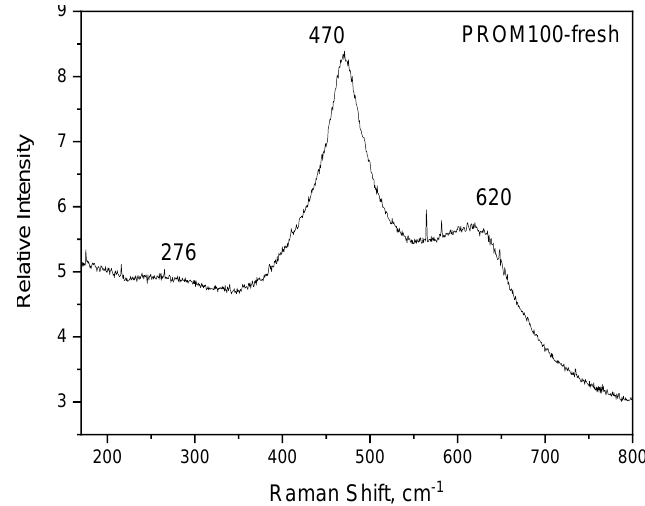
Figure 2. Raman spectrum of Cu/Pd/Rh doped on the CZ support, PROM100-fresh.